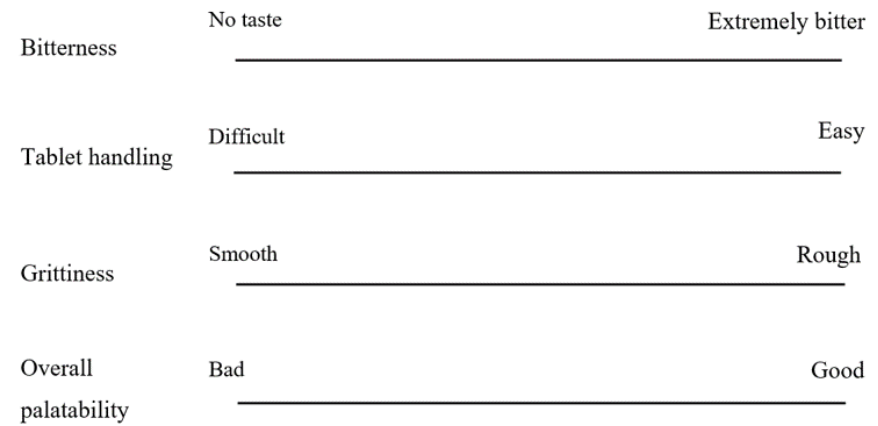
Figure 1. VAS line of bitterness, tablet handling, grittiness, and overall palatability.